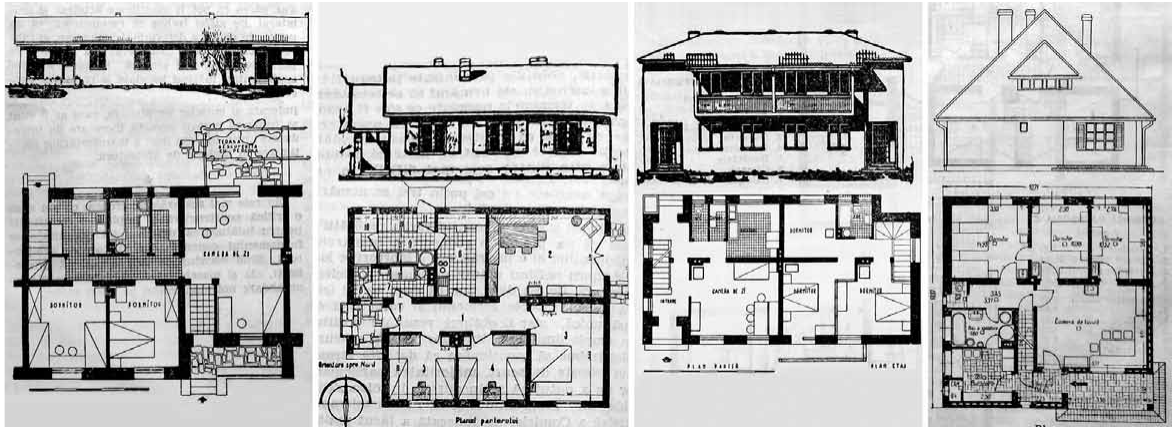
fig. 1. four of the winning entries. Source : Arhitectura , 1950, 2–3: